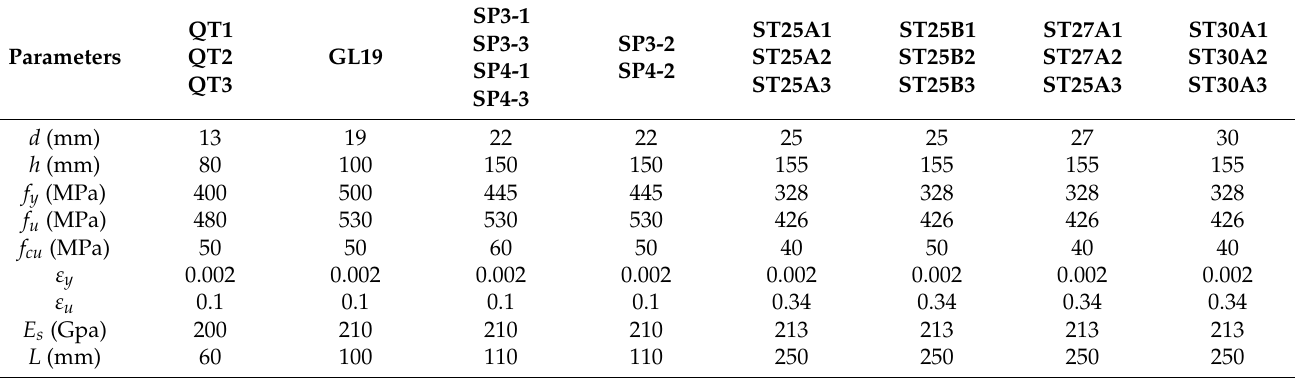
Table 2. The parameters of the experimental